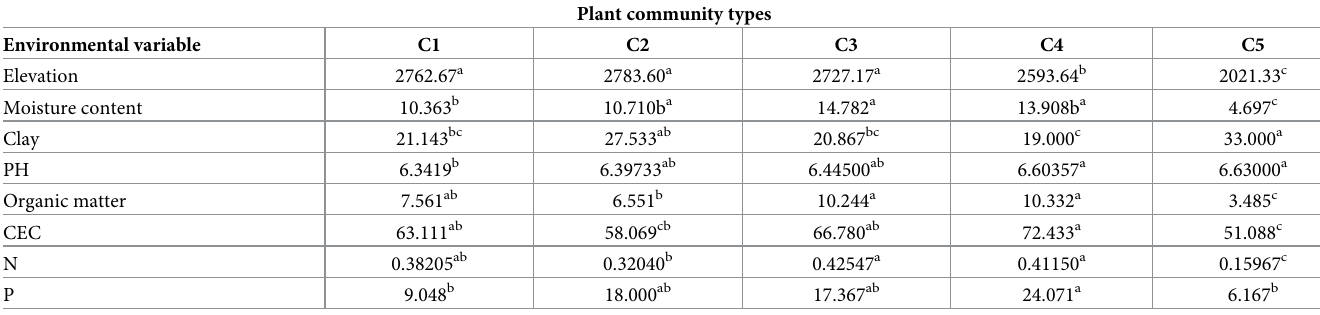
Table 9. Post-hoc comparison of means between environmental variables and plant